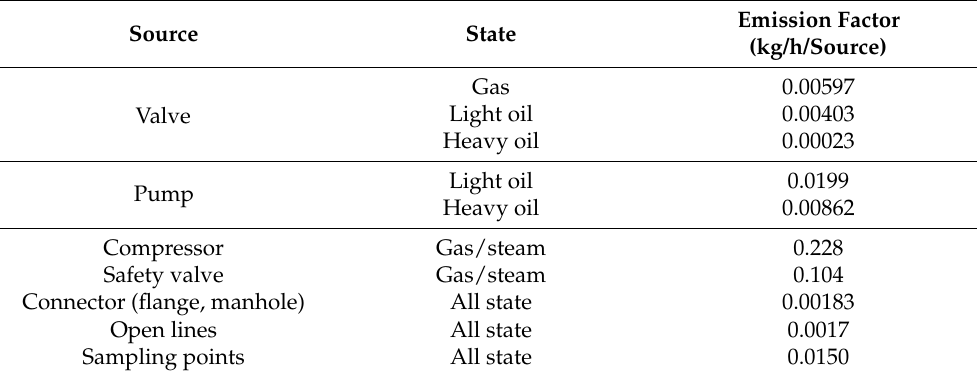
Table 5. In-piping leaking average emission